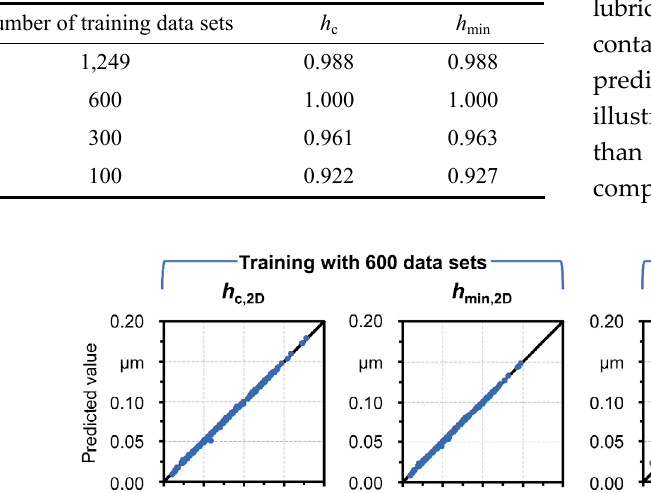
Table 11 Coefficients of determination of the prediction for the central and minimum film thicknesses for the infinite 2D line contact using an ANN with 12 neurons in each of two hidden layers after training with differently sized data sets.